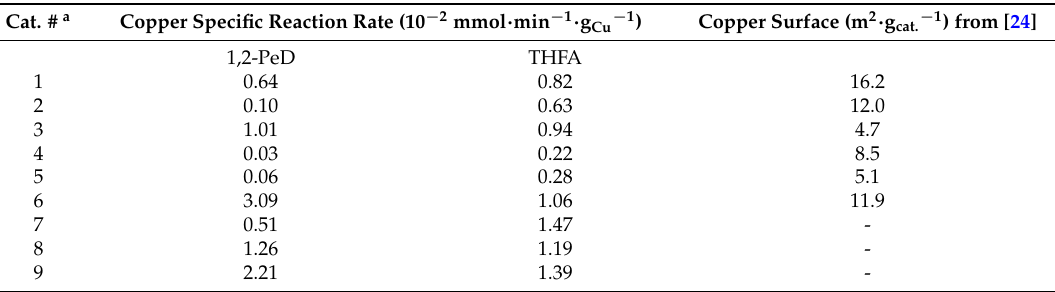
Table 2. Specific reaction rates referred to the copper